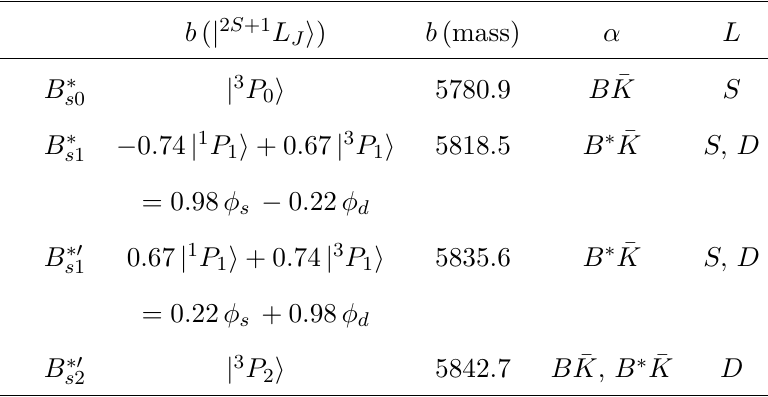
Table 2 . The related bare ¯ bs cores ( b ) and the B ( ∗ ) ¯ K ( α ) channels in the Hamiltonians of the physical B s states. The wave functions and mass spectrum (MeV) of the bare states are shown.